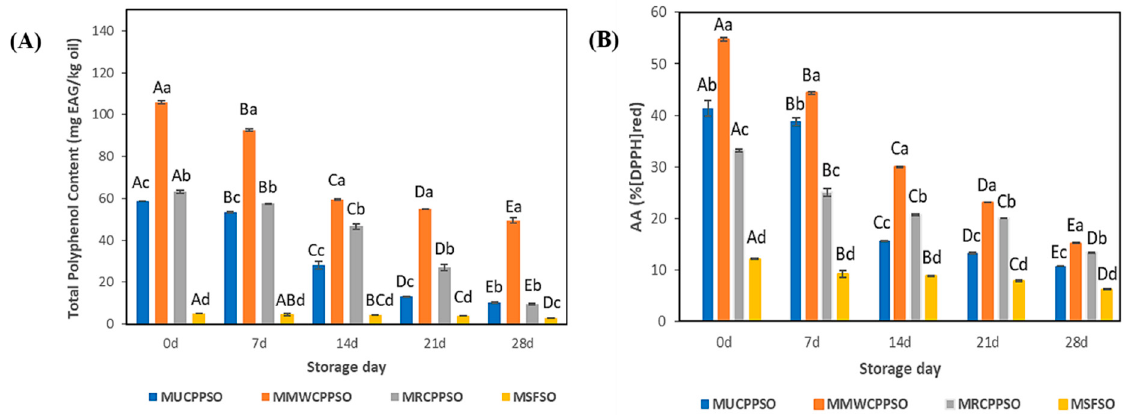
Figure 3. Evolution of total polyphenol content (mg EAG/kg oil) ( A ), and antioxidant activity (% (DPPH)red) ( B ) of the mayonnaises during storage. Values are means ± standard deviations (SD) of three independent determinations. Different lowercase letters represent significant differences between the mayonnaises ( p < 0.05). Different uppercase letters represent significant differences between storage times of each mayonnaise ( p < 0.05).